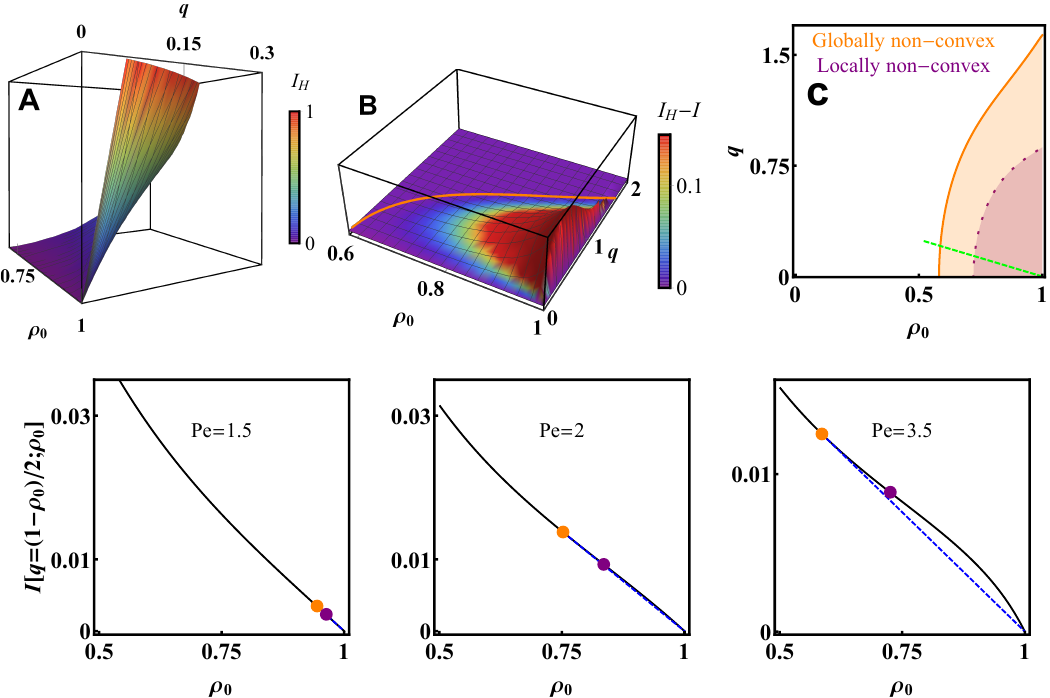
( ρ Figure 4: (A) The rate function I , q ) showing non-convexity and a pinch singu- H 0 = 1, q = 0 ) . (B) The difference between the rate function I larity at ( ρ and its H 0 convex hull I . The orange line is the boundary of the region of global non-convexity, given by (33). (C) The phase diagram for local and global non-convexity for I . Lo- H cal non-convexity is denoted by a dashed purple curve, given by the implicit relation = 0 with h h given in (31) together with (25). Global non-convexity is marked by 0 0 the orange curve and is given by the implicit relation (33). At large ℓ these regions s define local and global instability regions of the constant solution respectively (22). (cid:112) (Lower panels) Emergence of non convexity in I at increasing Pe > 2. An ex- H ample of a cross section for I , marked by a green line in panel (C) and given by H ) / 2. The dashed blue line is the convex hull construction. The orange q = ( 1 − ρ 0 and purple points corresponds to the intersection with the local and global convexity curves that are shown in panel